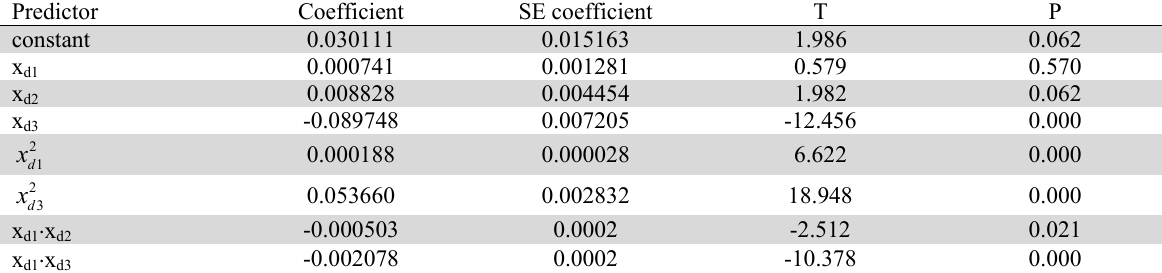
The MRA model for the prediction of strain energy density at belt edge Predictor Coefficient